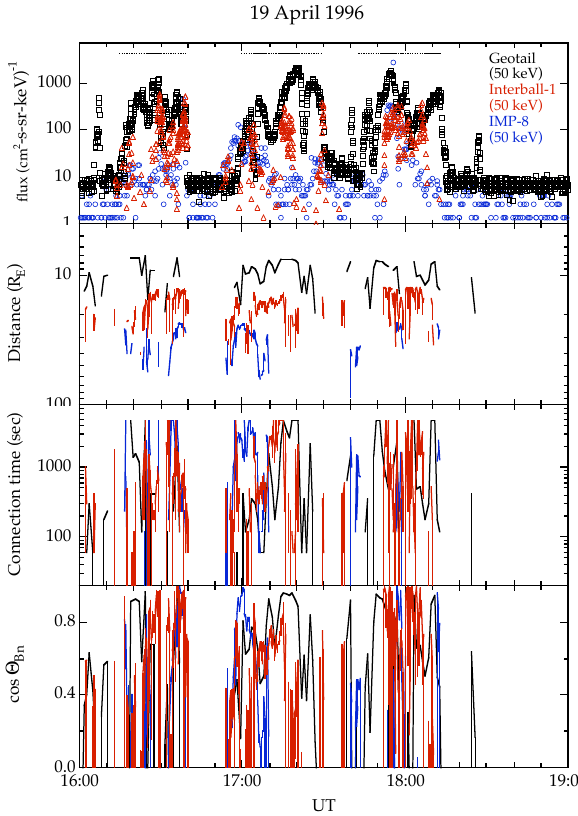
Fig. 7. A comparison of Geotail, Interball-1, and IMP-8 energetic ion observations with factors thought to control flux levels. The top panel presents energetic ion flux levels observed by Geotail (61.5– 73.7keV), Interball-1 (46.3–60keV), and IMP-8 (50–220keV). For comparison, the flux levels have been extrapolated to those expected at 50keV under an assumption of an exponential spectra with an e- folding energy of 26keV. The second panel presents the distances of each spacecraft from the bow shock along the IMF. The third panel depicts the length of time each field line had been connected to the bow shock when it encountered the observing spacecraft. The bot- tom panels presents cos 2 Bn , the angle between the IMF field line connecting observing spacecraft to the bow shock and the normal to the bow shock at the point of